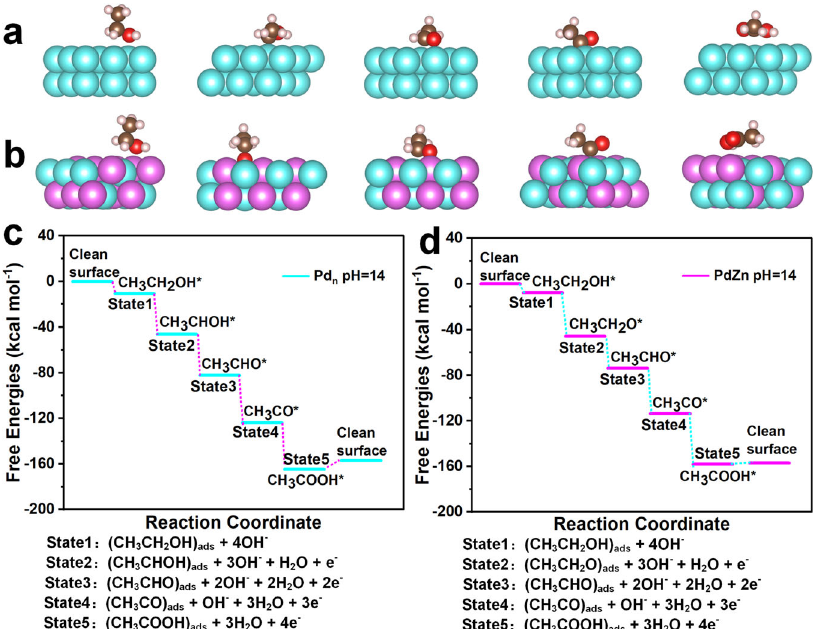
Fig. 4 DFT calculated reaction procedure of EOR on Pd – Pd sites and Pd – Zn dual sites. a DFT calculated models of Pd – Pd sites adsorbed with the reactive species from different EOR reaction states. b DFT calculated models of Pd – Zn dual sites adsorbed with the reactive species from different EOR